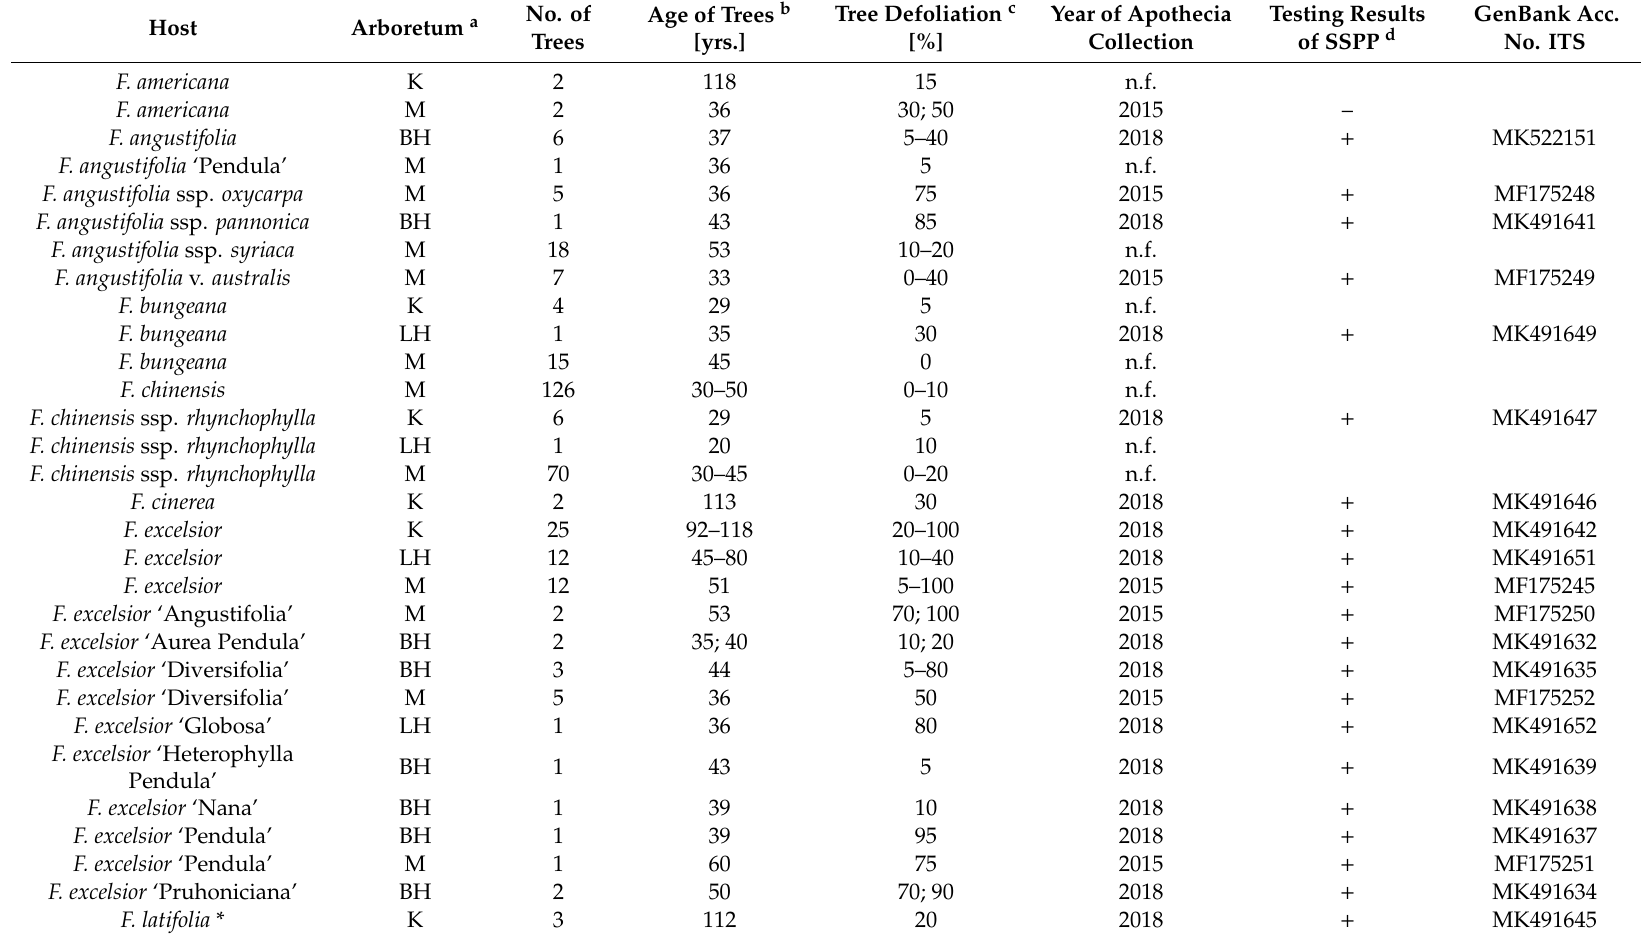
Table 2. Summary of Fraxinus taxa examined for the presence of Hymenoscyphus fraxineus in four Slovak arboreta, including the extent of tree defoliation, results of species–specific PCR, and GenBank accession numbers of representative